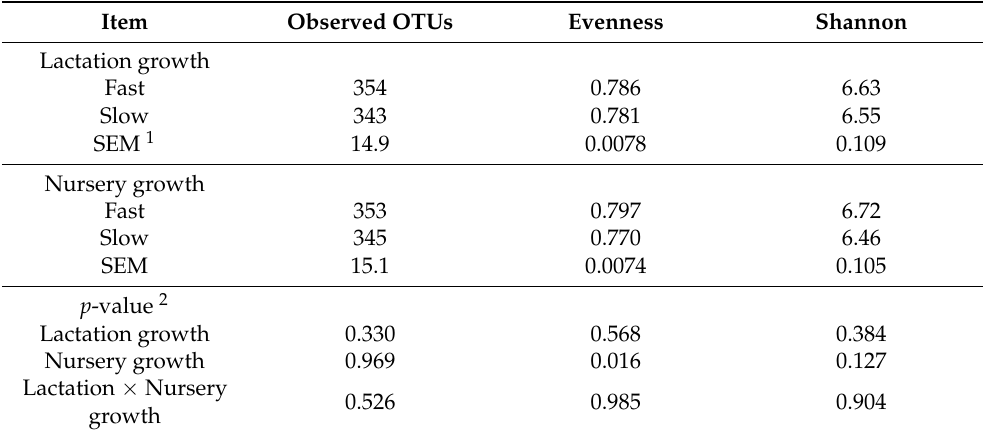
Table 4. Alpha diversity measured as observed in the OTUs, Pielou’s Evenness Index, and Shannon Index for pigs showing fast and slow growth during the lactation and nursery